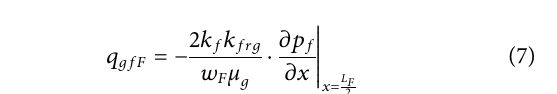
FIGURE 3 | Fracture distribution diagram of segmental fractured horizontal well mechanism model.